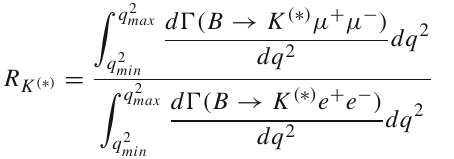
Fig. 5 Predictions of the observables P (cid:10) of (cid:16) C total , A FB , S 7 and F L in the . The decays are simulated in the SM, with the parameters θ 0 9 λ 5 ζ λ and ω λ set to zero. The 68% confidence intervals are shown for the SM using the expected post-fit precision of the non-local parameters (cid:16) C total statistical uncertainty (cyan band) and the combination of the statistical at the end of Run2 of the LHC. A sample of O ( 10 6 ) simulated 9 λ uncertaintywiththe B → K ∗ form-factoruncertainties(magentaband) B 0 → K ∗ 0 μ + μ − decays that include contributions from both short- given in Ref. distance and non-local components, is used to determine the parameters